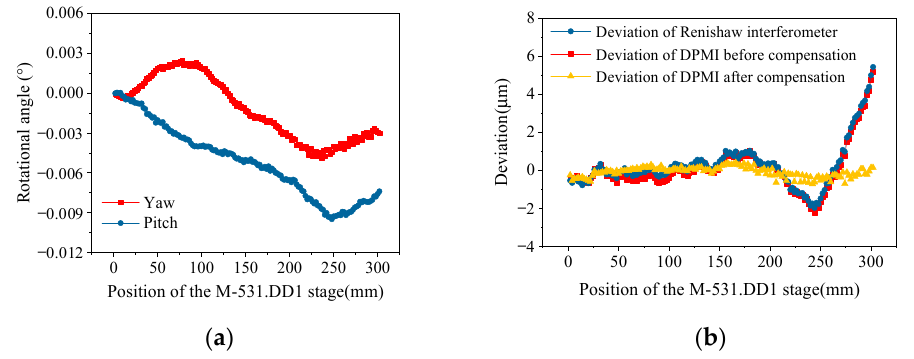
Figure 6. Displacement measurement comparison results: ( a ) measured rotational angles; ( b ) measured displacement results. Table 2. Statistical results of displacement measurement: comparison of experimental data. Displacement Deviations with the Stage Maximum Standard Position Deviation ( µ m) Deviation ( µ m) Renishaw interferometer 5.448 1.225 DPMI before angle compensation 5.207 DPMI after angle compensation